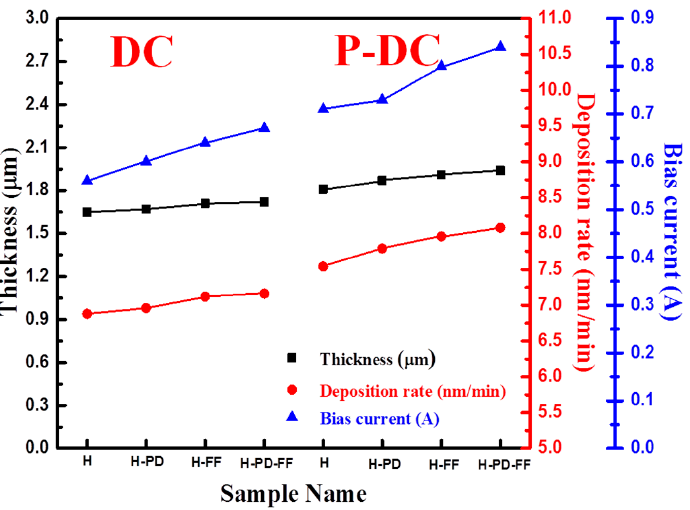
Figure 4. Deposition rate and final thickness of TiN and corresponding I b as function of the HiPIMS operating mode under DC and P-DC bias.